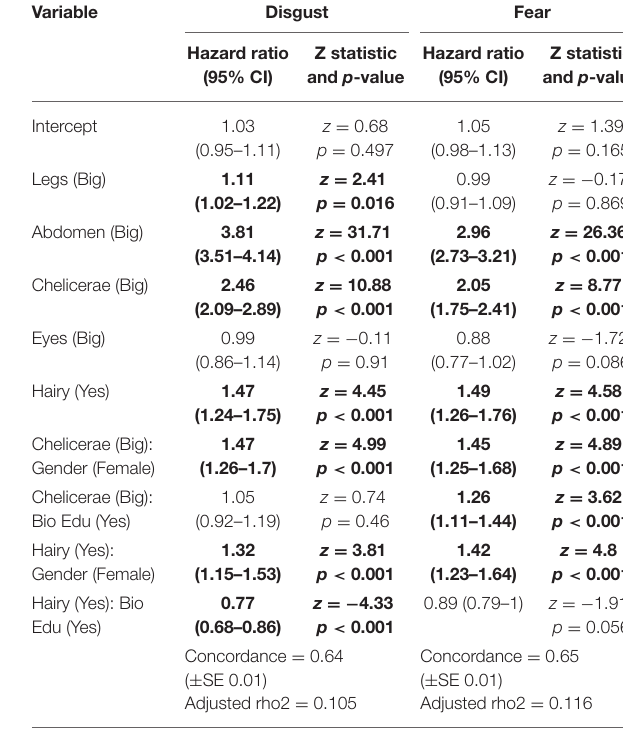
Variables where p < 0.05 are shown in bold. Only statistically significant interactions are included. CI, confidence